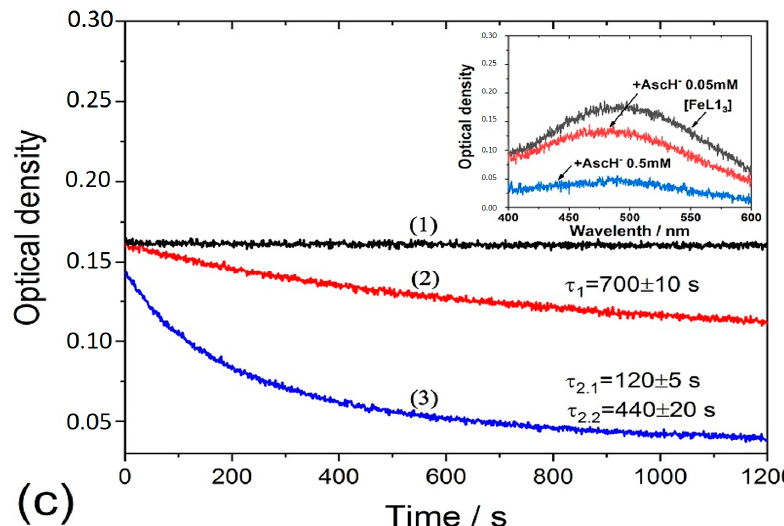
Figure 2. ( a ) Absorption spectra of ascorbic acid (0.05 mM), FeCl 3 (0.05 mM), and [FeL1 3 ] chelate complex (0.05 mM) in a water solution at pH = 4.8; ( b ) time profile of the changes of optical density at 525 nm of FeL1 3 chelate complex aqueous solution at pH = 7.4 in the absence (1) and presence of ascorbic acid at 0.05 mM (2) and 0.5 mM (3) at room temperature (25 ◦ C); ( c ) similar time profiles measured at pH = 4.2.